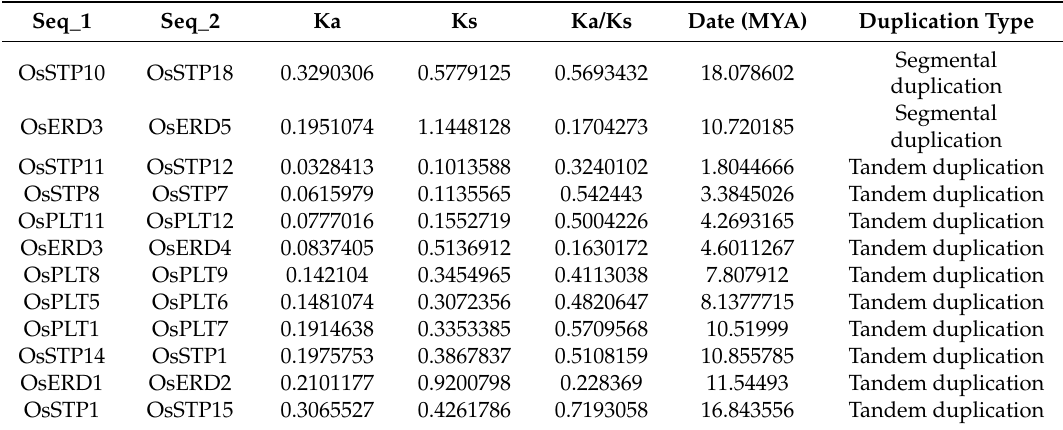
Synonymous (Ks) and nonsynonymous (Ka) substitution rates of duplicate gene pairs (Ka/Ks ratios).